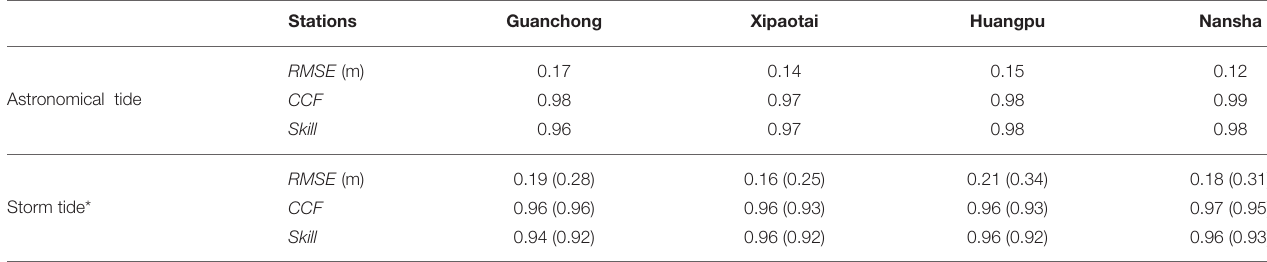
TABLE 1 | Evaluation of model results: the measurements ( M n ) used to calculate RMSE , CCF , and Skill for the Astronomical Tide run are the reconstructed astronomical tides from the harmonic analysis results of the observed long-term total water levels, while the measurements used for the validation of the Storm Tide runs are the total water level observations.